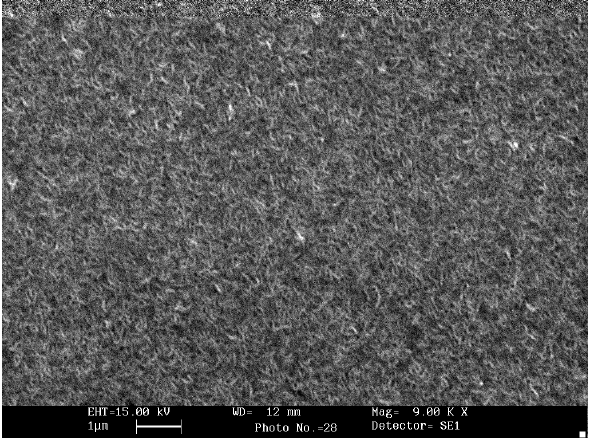
Figure 8 . The scanning electron micrographs of thin film deposited at 458K-substrate temperature.